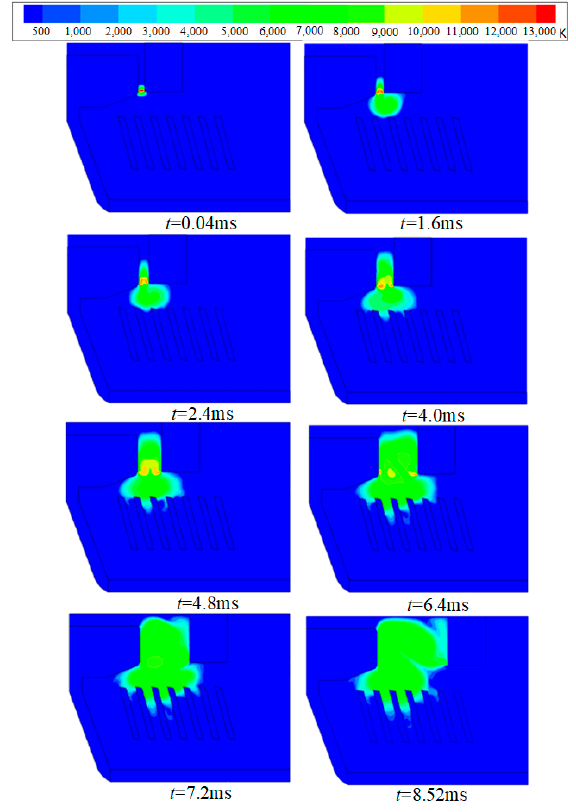
Figure 3. Temperature distribution.